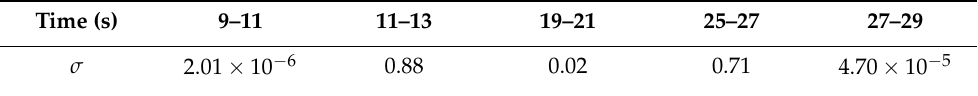
Figure 8. Experimentally measured speed of both coupled shafts components before, during, and after the overload condition. Table 2. Variance of ω M